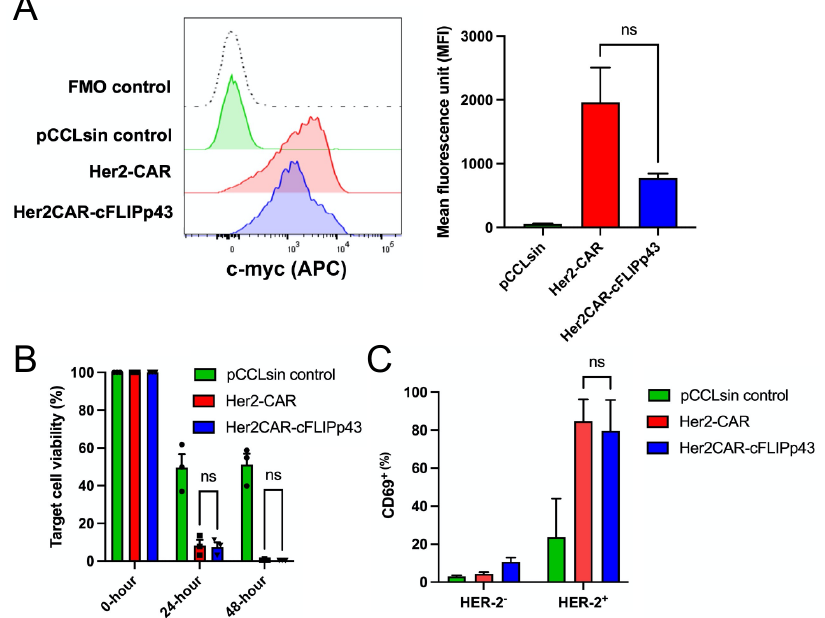
Figure 2. Comparison of CAR expression, in vitro cytotoxicity and CD69 activation marker between Her2 ‐ CAR and Her2CAR ‐ cFLIPp43 CAR T cells. ( A ) Representative histogram plots compared the CAR expression (c ‐ myc) between Her2 ‐ CAR and Her2CAR ‐ cFLIPp43 CAR T cells at day 7 post ‐ transduction by flow cytometric analysis. T cells transduced with pCCLsin control served as the experimental control. Bar graph displaying the percentage of c ‐ myc + cells (mean ± SEM) from three independent donors. Dead cells were excluded by Zombie NIR viability dye at analysis. Statistical analysis was performed by one ‐ way ANOVA with Tukey’s multiple comparison test (ns: non ‐ sig ‐ nificant). ( B ) Luciferase cytotoxicity assay showing specific lysis of Her2 ‐ CAR and Her2CAR ‐ cFLIPp43 CAR T cells of Her2 + Luciferase + ‐ MCF ‐ 7 target cells. CAR T cells were incubated with target cells at 10:1 ratio and assessed at 24 and 48 h post ‐ incubation. Bar chart represents the percent of target cell viability (mean ± SEM) of three independent donors, calculated by dividing the lucif ‐ erase emission of the sample well over the luciferase reading of untreated target cells. Statistical cFLIPp43 CAR T cells were co ‐ cultured with HER ‐ 2 + MCF ‐ 7 target cells at 2:1 ratio for 24 h. GFP ‐